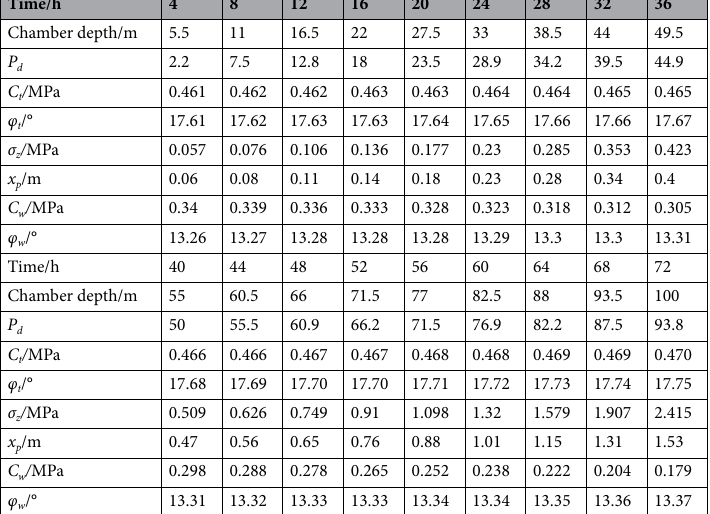
Table 6. Slice width distribution pattern and evolution weak layer parameters of a 6.2-m-wide coal pillar.